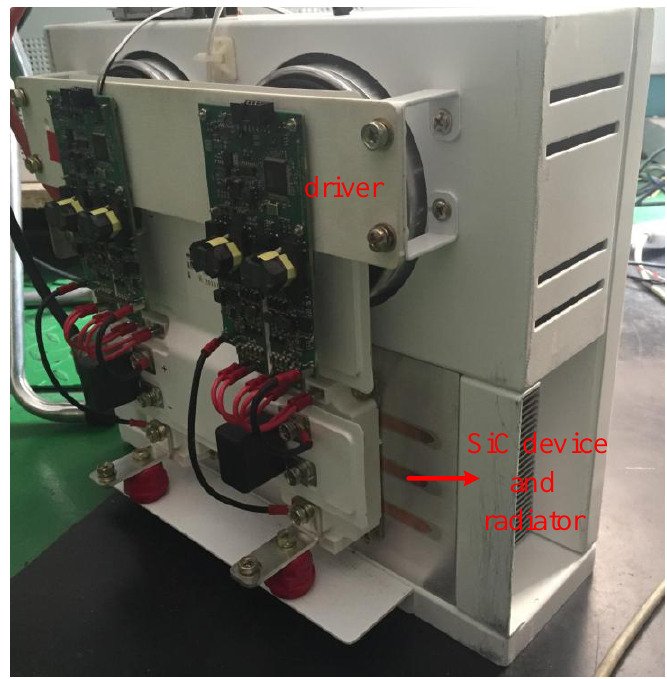
Figure 19. Location of the SiC device and radiator.